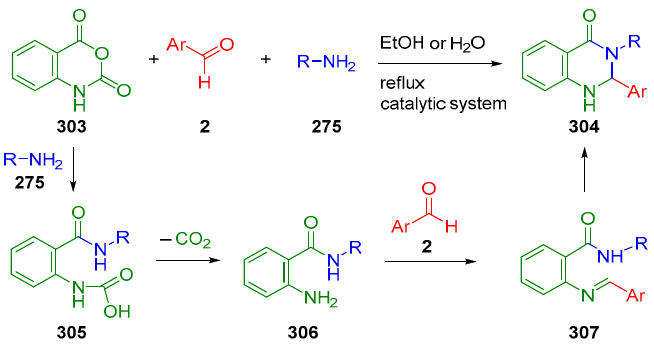
Scheme 92. The reaction of isatoic anhydride with aldehydes and